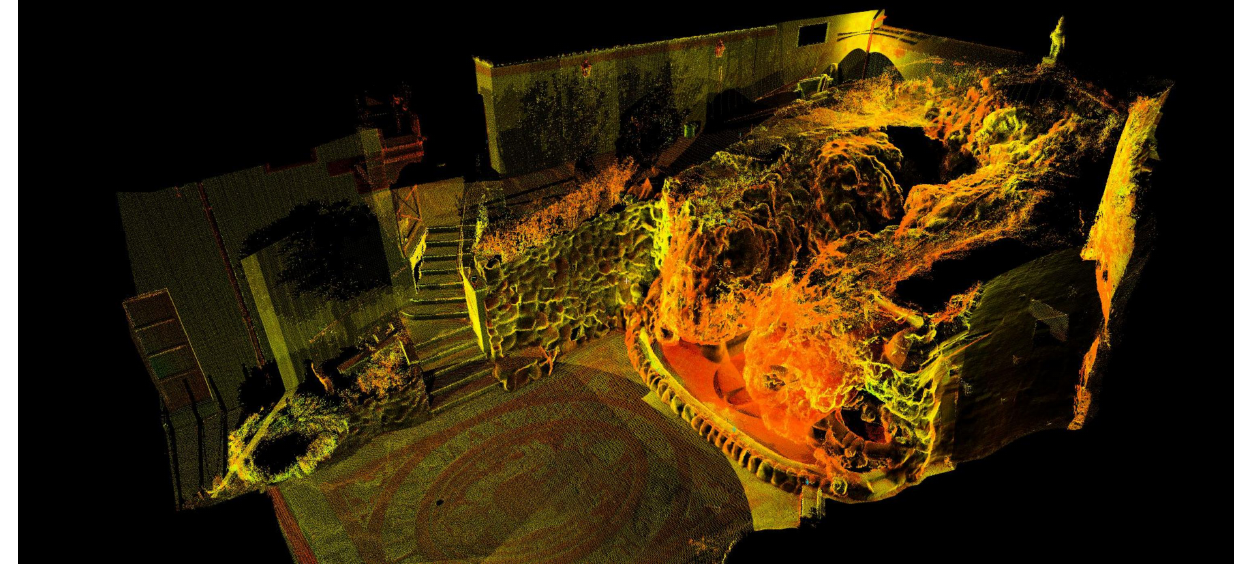
Figure 7. Total points cloud